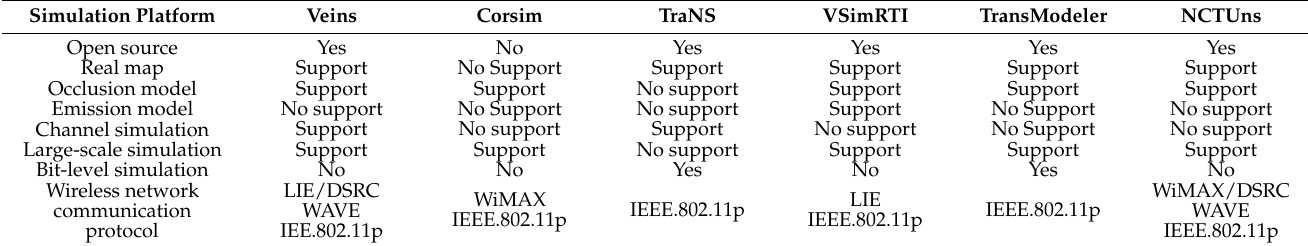
Table 1. Comparison of typical Internet of Vehicles simulation platforms.